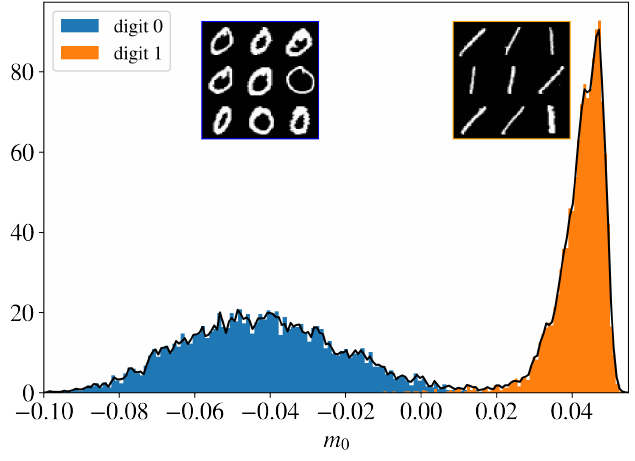
Figure 7: Histogram of the projection m along its first principal component. We show in blue and orange the histogram of the magnetizations of only the 0 and 1 digits. It is clear that m both